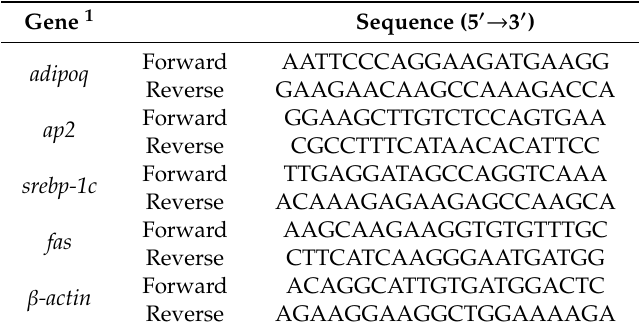
Table 1. Primer sequence of lipogenic-related genes for RT–PCR. Gene 1 Sequence (5 (cid:48) → 3 (cid:48)